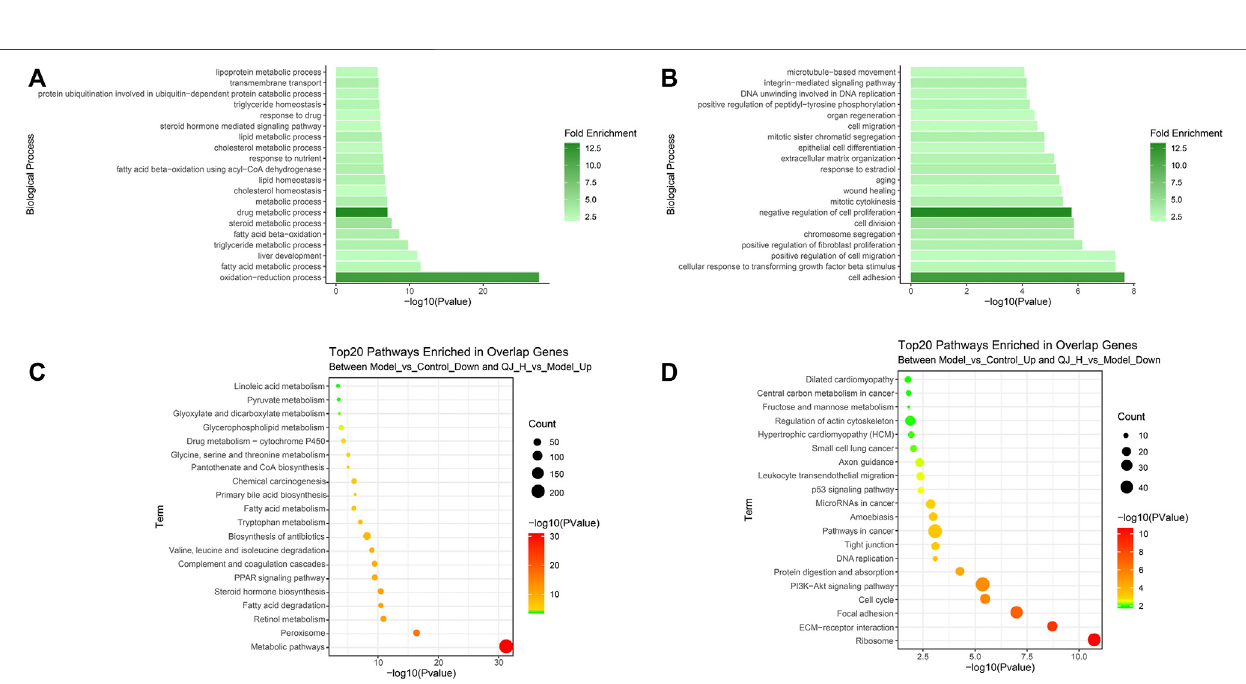
FIGURE 6 | GO and KEGG enrichment analysis of the DEG target of QJ-H. (A) GO analysis histogram of the 1590 overlapping upregulated DEGs between Model vs.Control-downandQJ-Hvs.Model-up; (B) GOanalysishistogramofthe1444overlappingdownregulatedDEGsbetweenModelvs.Control-upandQJ-Hvs.Model- down; (C) KEGG enrichment analysis of the 1590 overlapping upregulated DEGs between Model vs. Control-down and QJ-H vs. Model-up; (D) KEGG enrichment analysis of the 1444 overlapping downregulated DEGs between Model vs. Control-up and QJ-H vs. Model-down.